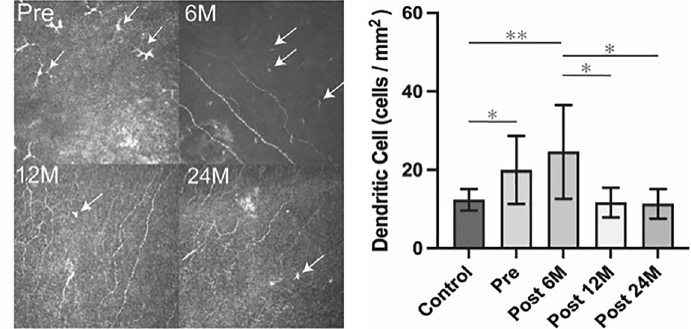
Figure 2. Change in dendritic cells (DCs) pre- and post-DMEK. DCs were counted with IVCM. Left: DCs (white arrows) are identified owing to high brightness and their typical dendritic morphology. Right: DCs in preoperative BK corneas are significantly more than those in controls. Number of DCs at 6 months post DMEK is significantly higher than that of controls, and at 12 and 24 months after DMEK. BK bullous keratopathy, DMEK Descemet membrane endothelial keratoplasty, IVCM in vivo confocal microscopy, Pre pre-operative, Post postoperative, M months after surgery. *p < 0.05, **p <